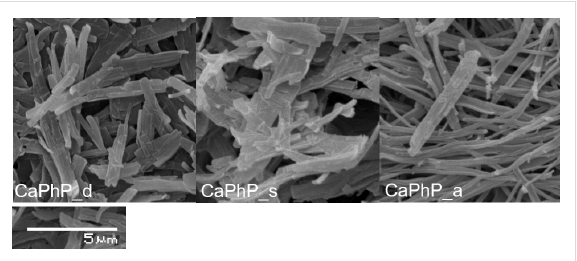
Figure 2: SEM pictures of calcium phenylphosphonate particles pre- pared by addition of chloride solution using the “drop by drop” (CaPhP_d) and “in several portions” methods (CaPhP_s) and “all at once”